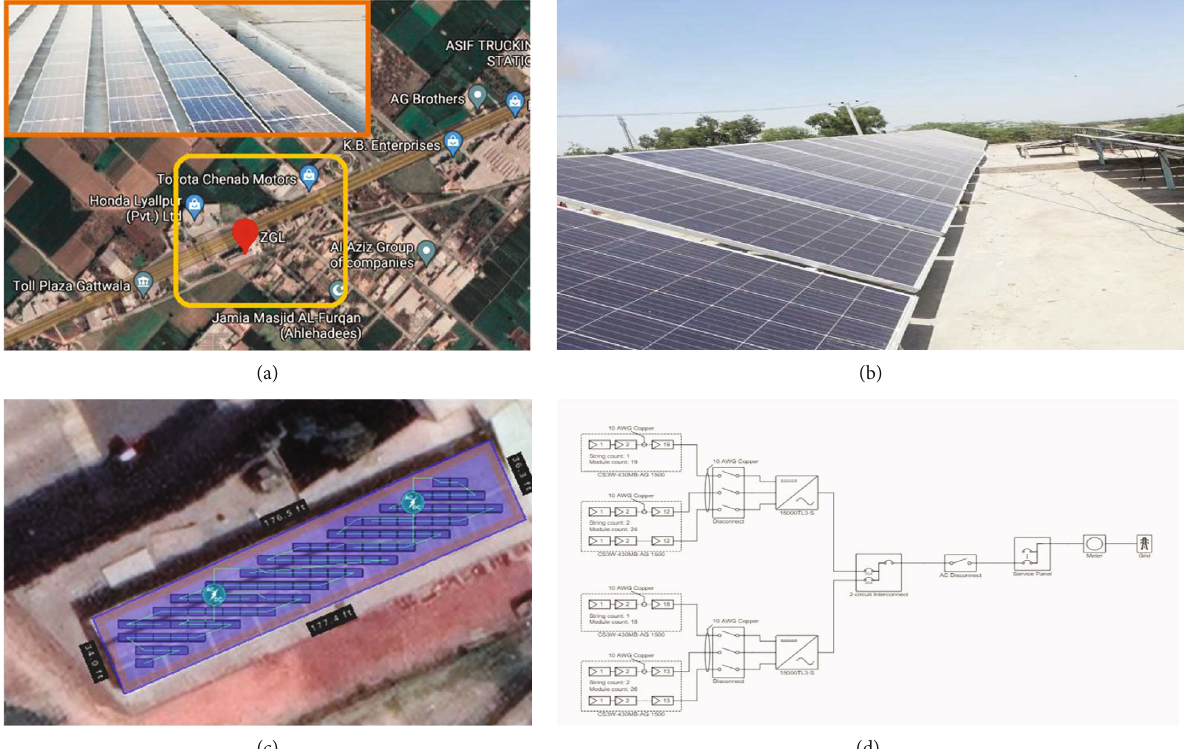
Figure 2: Overview of installed PV system (15 kWp): (a) location on map in Faisalabad; (b) real-time overview; (c) string diagram; (d) single line diagram